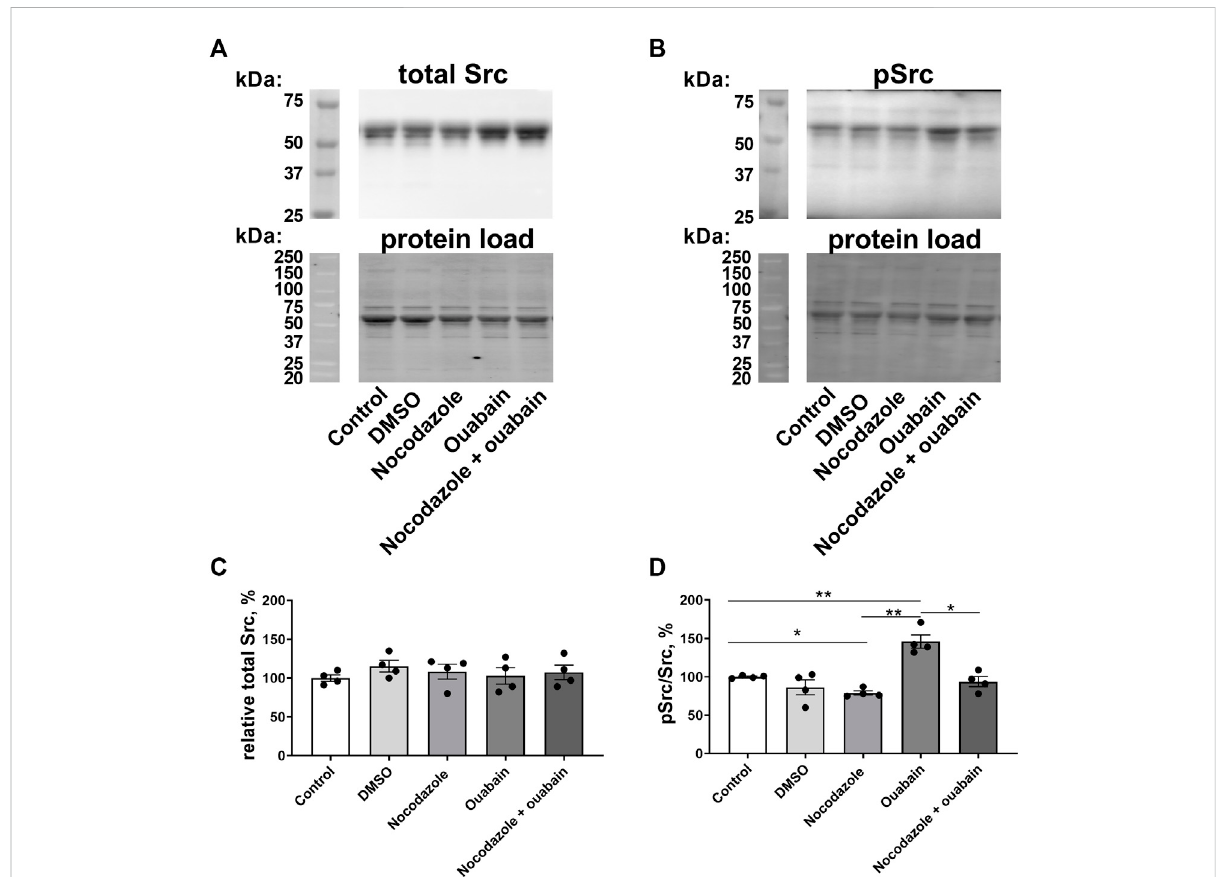
FIGURE 6 Ouabain increased Src kinase phosphorylation, while nocodazole prevented thisincrease. Representative blots from Western blotexperiments where membranes were stained with either antibodies against total Src kinase (A) or with antibody against phosphorylated Src (B) . Lower panels in (A,B) show total protein load detected with stain-free membrane. Semi-quanti fi cation of total Src expression in A7r5 cells under control conditions, exposed to vehicle (DMSO), pre-incubated with nocodazole (10 µM), with ouabain (10 µM) or with a combination of nocodazole and ouabain (C) . Src phosphorylation relative to total Src content under control conditions, exposed to vehicle (DMSO), pre-incubated with nocodazole (10 µM), with ouabain (10 µM) or with a combination of nocodazole and ouabain (D) . n = 4, * and **, p < 0.05 and 0.01 (one-way ANOVA followed by Sidak ’ s multiple comparisons test in (C,D)